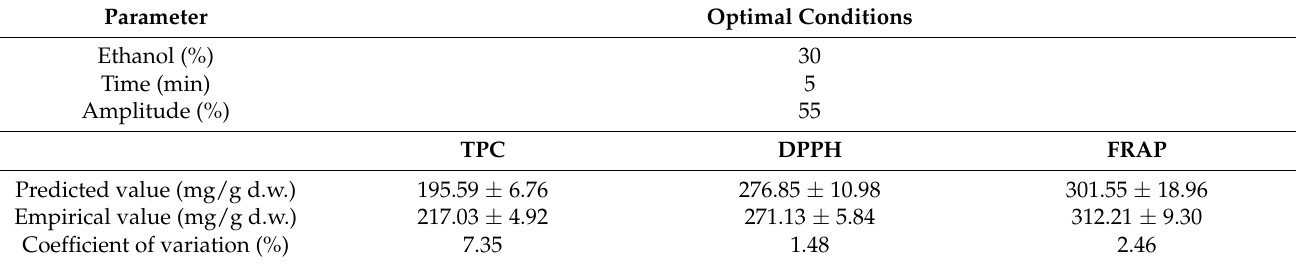
Table 3. Optimal conditions of extraction and predicted and empirical values of the model are expressed as the mean ± SD ( n = 3).